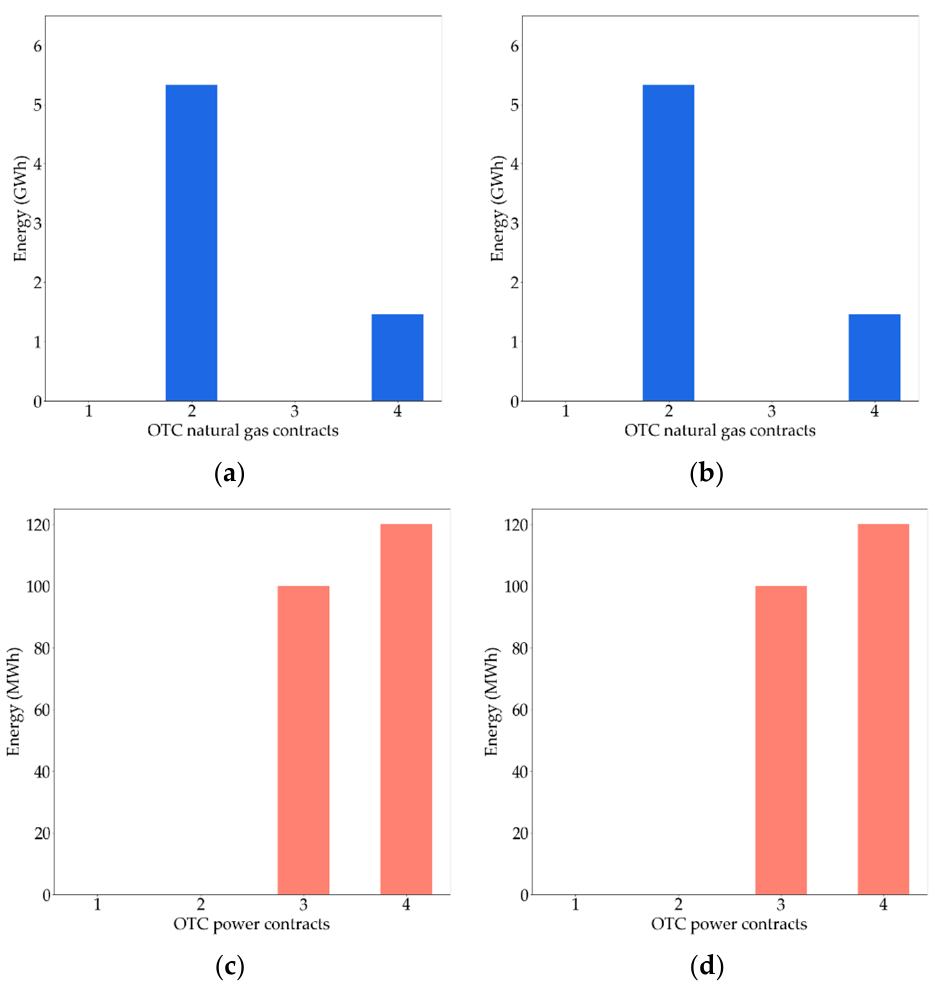
Figure 13. Bilateral contracts selected. ( a ) Natural gas purchases per day and per bilateral contract with storage; ( b ) natural gas purchases per day and per bilateral contract without storage; ( c ) electricity sold per hour and per bilateral contract with gas storage; ( d ) electricity sold per hour and per bilateral contract without gas storage.